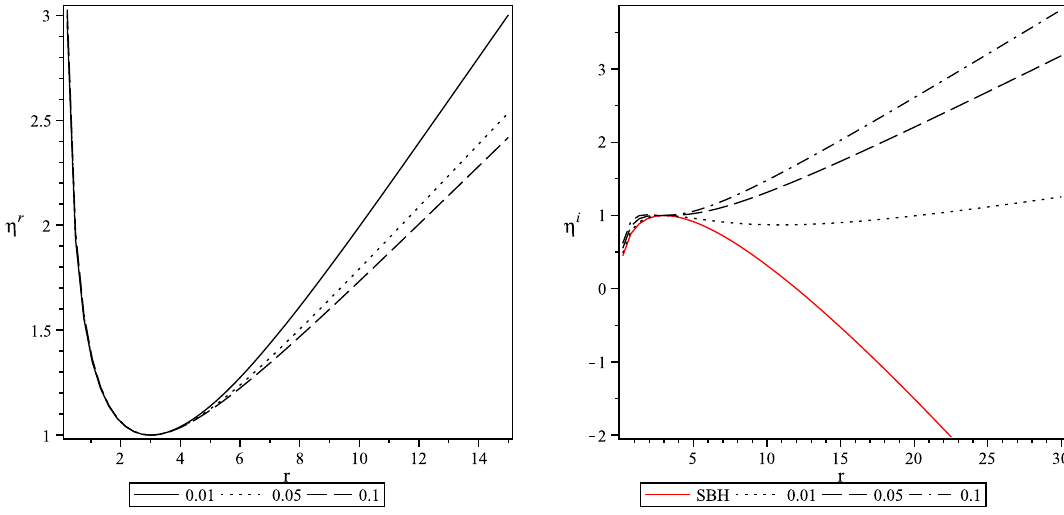
Fig. 6 Variation of geodesic vectors for M = 1, w q = − 0 . 95, a = 0 . 1 and different mentioned values of q ; left figure: radial geodesic vector with ICI, right figure: angular geodesic vector with ICI; solid line curve represents the corresponding variation for